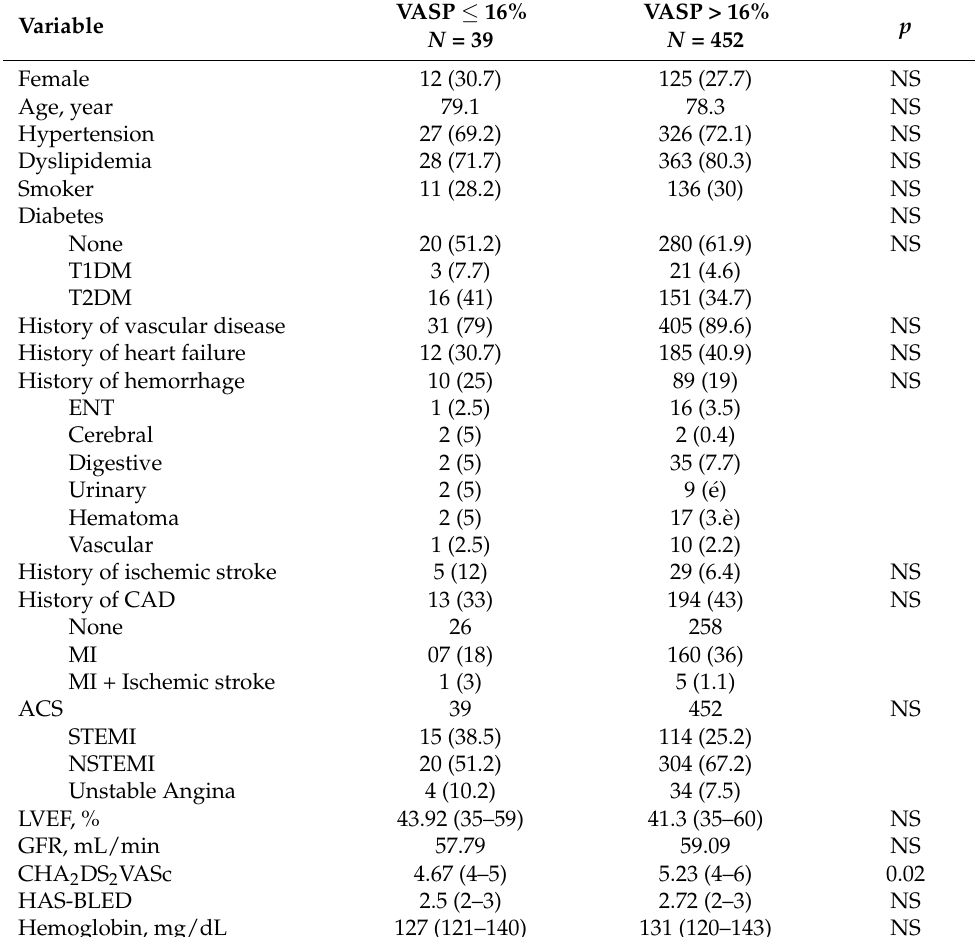
Table 5. Baseline characteristics for patients with six months follow-up, VASP cut-off 16% ( N = 491).